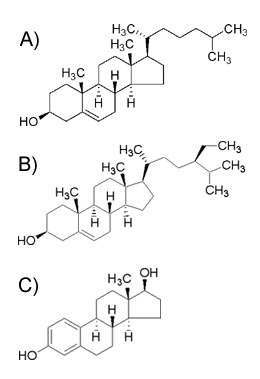
Chemical structures of (A) cholesterol (B) β-sitosterol (β-sit), and (C) 17β-estradiol (E2).